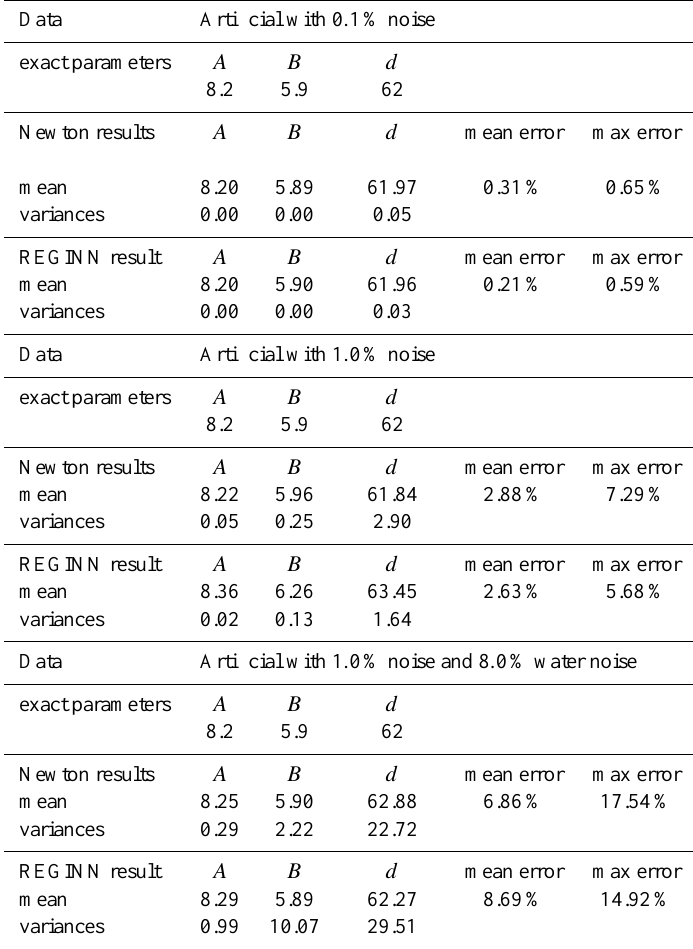
Table 1. Statistics for the inversion of artificial data. The uppermost part contains the inversion results for artificial data with 0 . 1% white noise added, the middle part artificial data with 1 . 0% noise. The lowermost part shows inversion results to artificial data with 0 . 1% white noise added after the seasonal forcing already contained noise of about